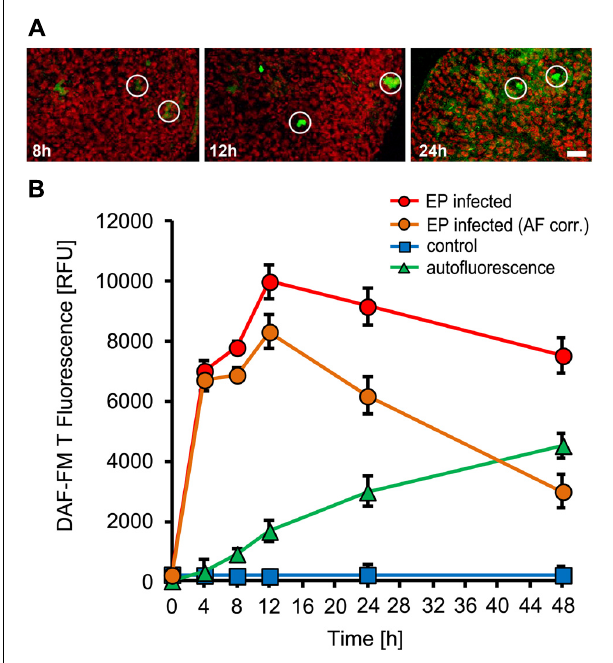
FIGURE 2 | NO accumulation in Arabidopsis leaves upon inoculation with the non-adapted powdery mildew fungus, Erysiphe pisi . Leaves of Arabidopsis thaliana Col-0 were harvested at the indicated times after inoculation and used to detect intracellular NO by infiltration of the NO sensitive dye DAF-FM DA. (A) Confocal images of powdery mildew infection sites (white circles) taken at 8, 12, and 24 h post-inoculation. (B) Time course of NO accumulation at infection sites (red circles) and in non-infected control leaves (blue squares). Autofluorescence at infection sites was quantified without prior DAF-FM DA staining (green triangles) and these values were used to correct NO levels (orange circles). All data represent the mean ( ± SD) of 20 infection sites taken from four different leaves of two different plants. Bar = 50 μ M.